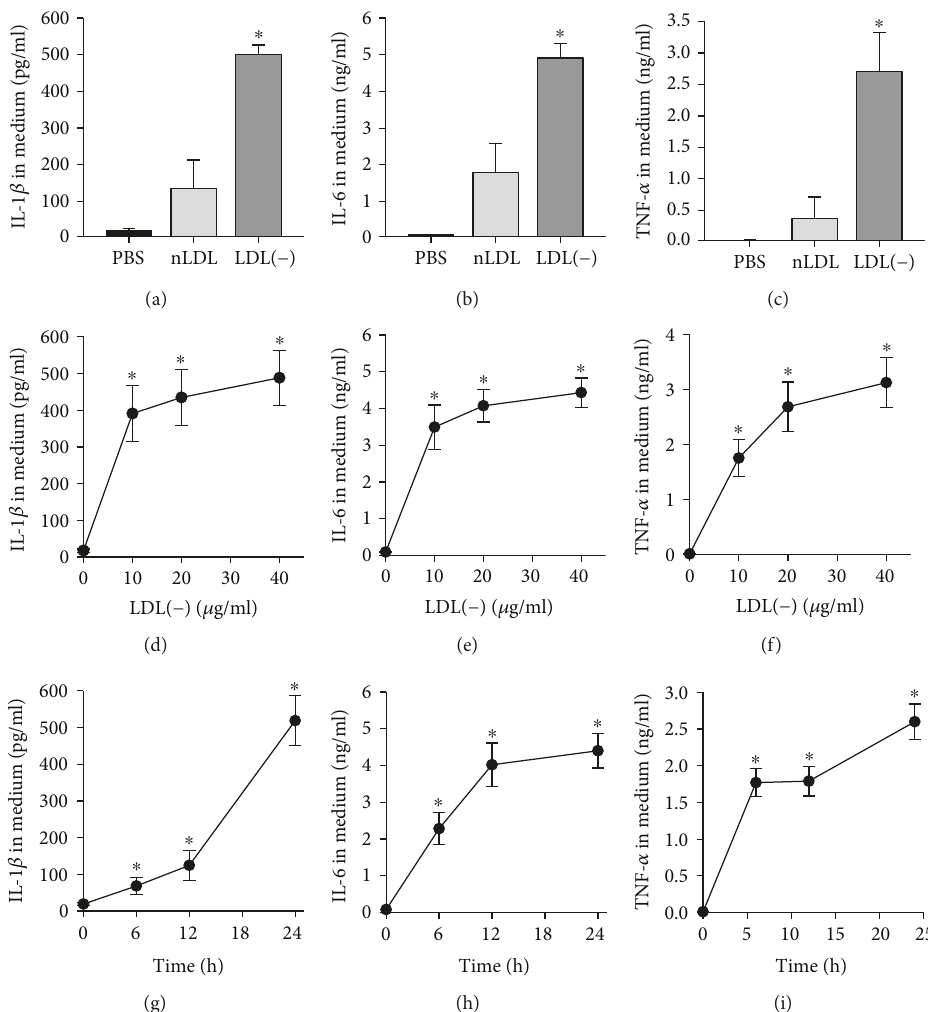
Figure 2: E ff ects of nLDL and LDL(-) on production of IL-1 β , IL-6, and TNF- α in THP-1 macrophages. THP-1 macrophages were incubated with 20 μ g/ml of nLDL or LDL(-) for 24 h, then levels of IL-1 β (a), IL-6 (b), and TNF- α (c) in the medium were measured by ELISA. Values are the mean ± SD of fi ve independent experiments. Di ff erences between means were evaluated using Student ’ s t -test. ∗ p < 0 05 , compared to PBS- and nLDL-treated cells. Cells were incubated with 0, 10, 20, or 40 μ g/ml of LDL(-) for 24h (d – f) or incubated with 20 μ g/ml of LDL(-) for 0, 6, 12, or 24h (g – i). Then, levels of IL-1 β (d, g), IL-6 (e, h), and TNF- α (f, i) in the medium were determined by ELISA. Values are the mean ± SE of fi ve (in (d – f)) or four (in (g – i)) independent experiments. Data was analyzed by one-way ANOVA followed by Tukey ’ s multiple comparison test. ∗ p < 0 001 , compared to 0 μ g/ml of LDL(-) or 0